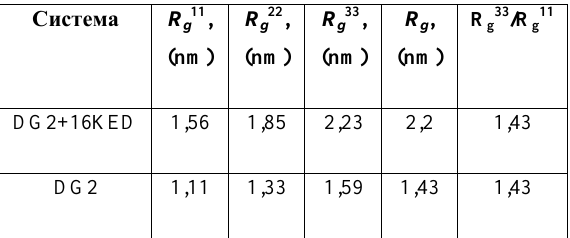
(curve 1) is between distribution for dendrigraft atoms (curve2) and peptide atoms (curve